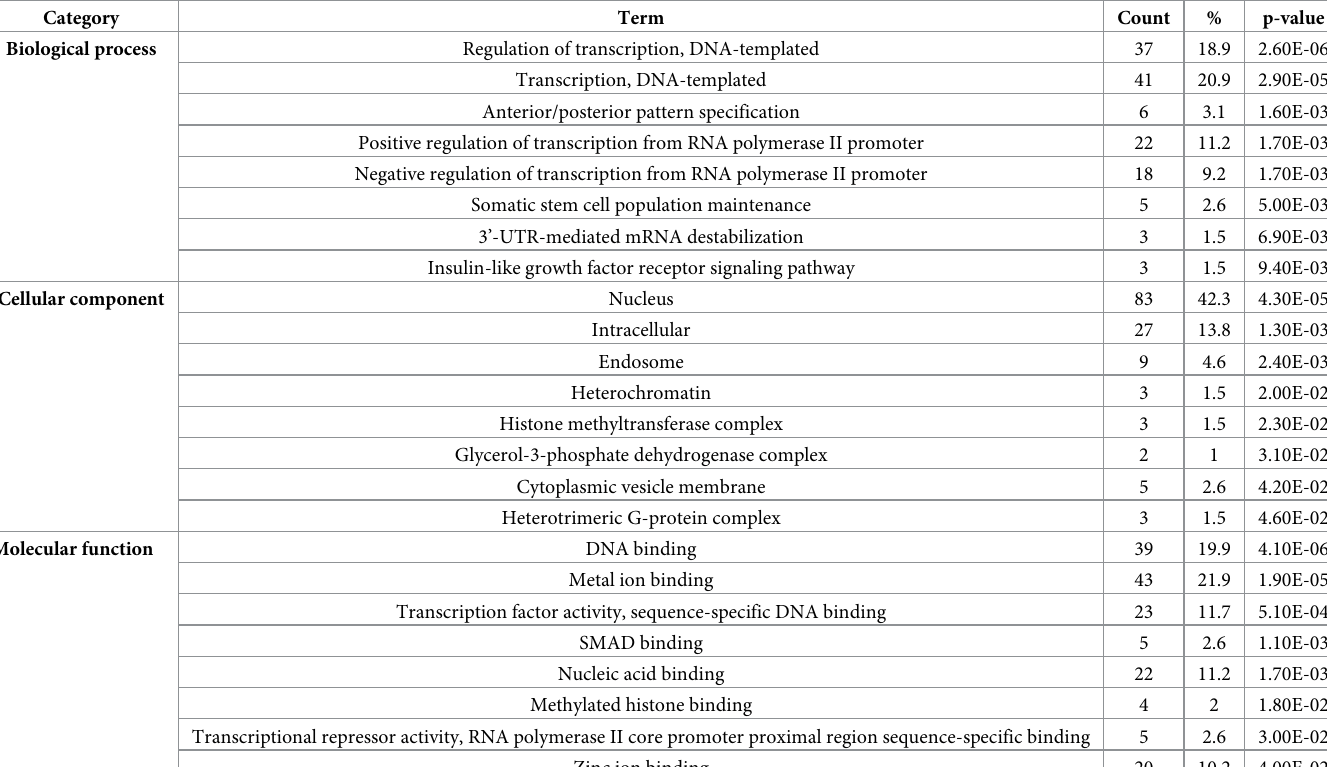
Table 5. GO analysis of miR-181b-5p, miR-222-3p and let-7a-5p target genes.